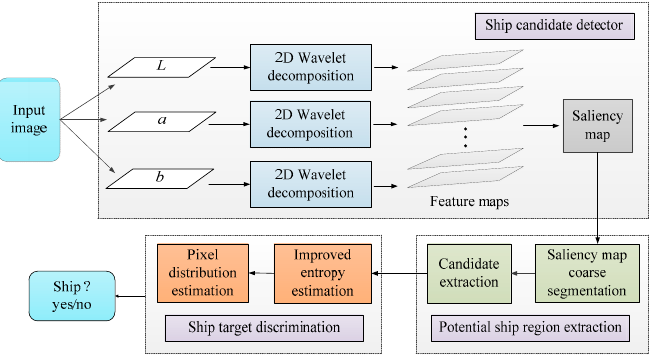
Figure 1. Diagram of the proposed ship detection framework.